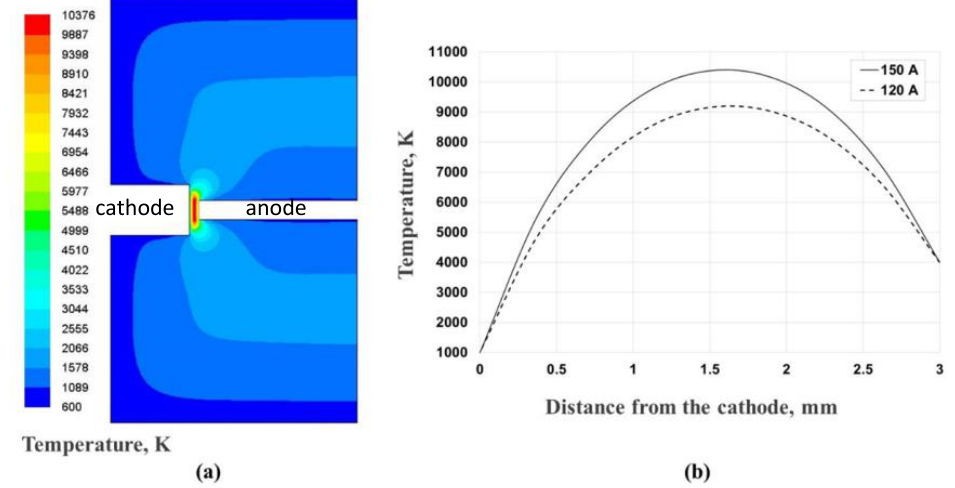
Figure 11. ( a ) Simulated temperature distribution inside the reactor at 150 A and ( b ) one dimensional (1D) temperature profiles along the centerline between the anode and the cathode at 120 A (dashed line) and 150 A (continuous line).